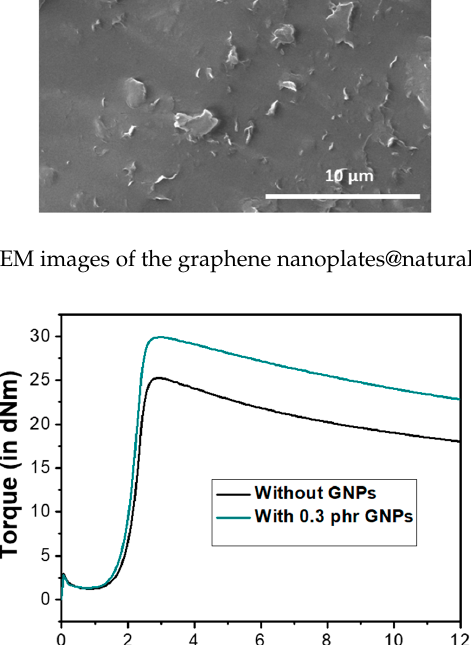
Figure 4. Torque-time curves of natural rubber composites without (black curve) and with (green curve) 0.3 phr GNPs content.